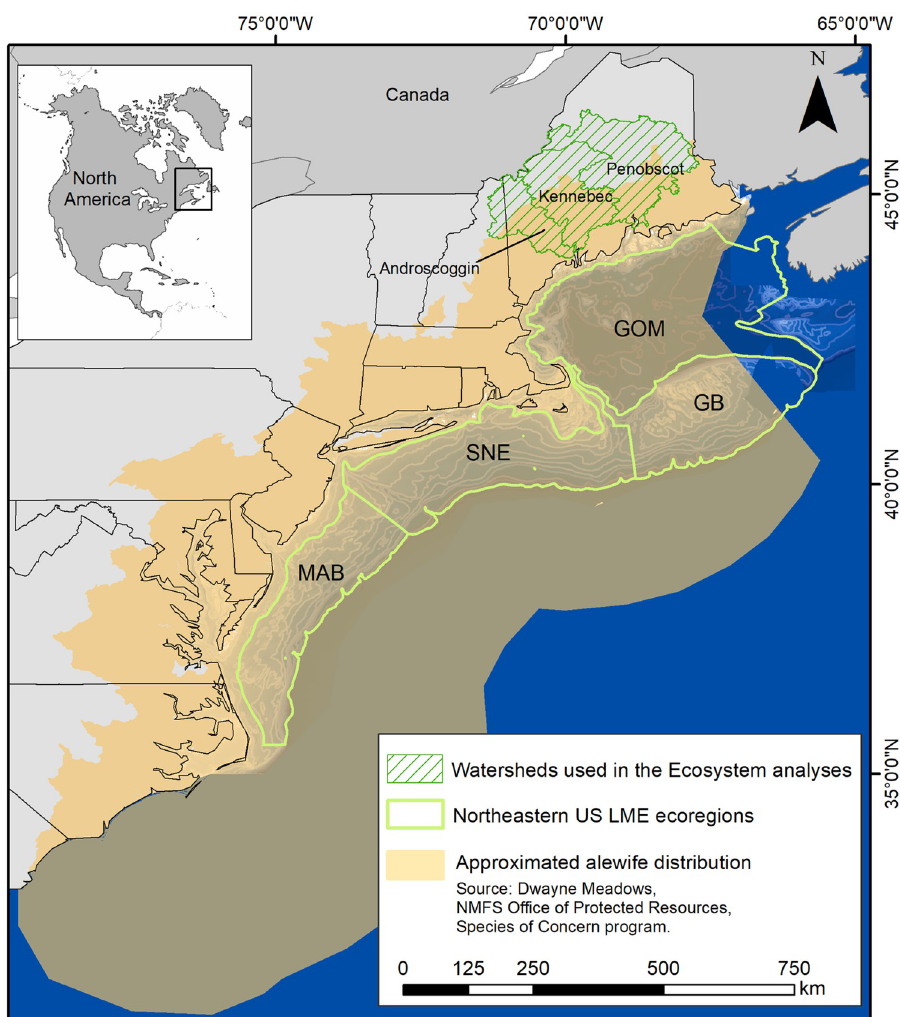
Fig 1. Map of the study area and sub-regions included in both models. This map shows the bathymetric profile of the coastal region, and NEUS LME ecoregions: The Gulf of Maine (GOM), Georges Bank (GB), Southern New England (SNE), and Middle Atlantic Bight (MAB). The limits of the tan region also represent the US Exclusive Economic Zone